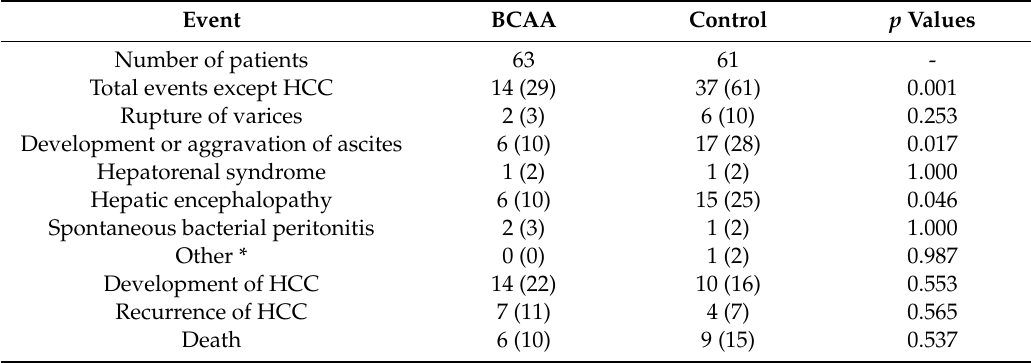
Table 2. Major cirrhosis-related events in the BCAA and control